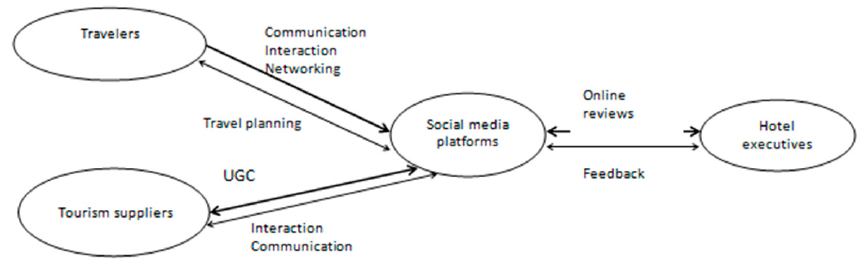
Figure 7. UGC model for travel planning in hospitality sector.